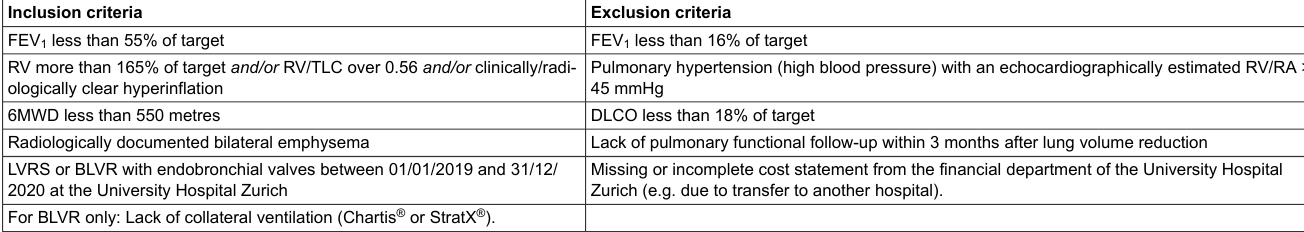
Table S1: In- and exclusion criteria.